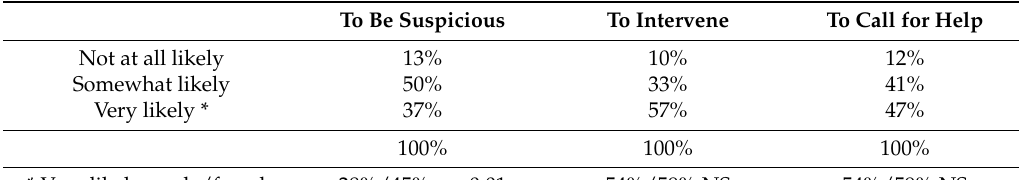
Table 1. Likelihood of Bystander Reactions in Three Situations.